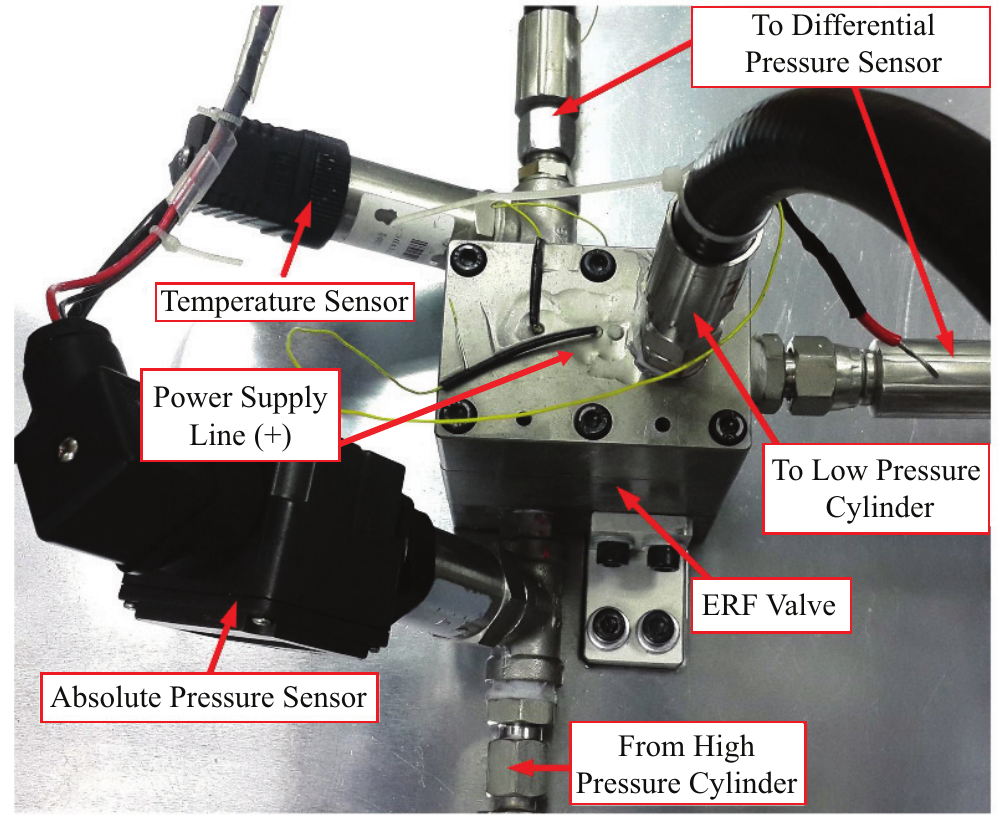
Figure 7. A close up view of the assembled ERF valve in the